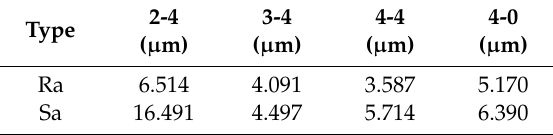
Table 4. Cu–Ni composite coatings surface roughness.